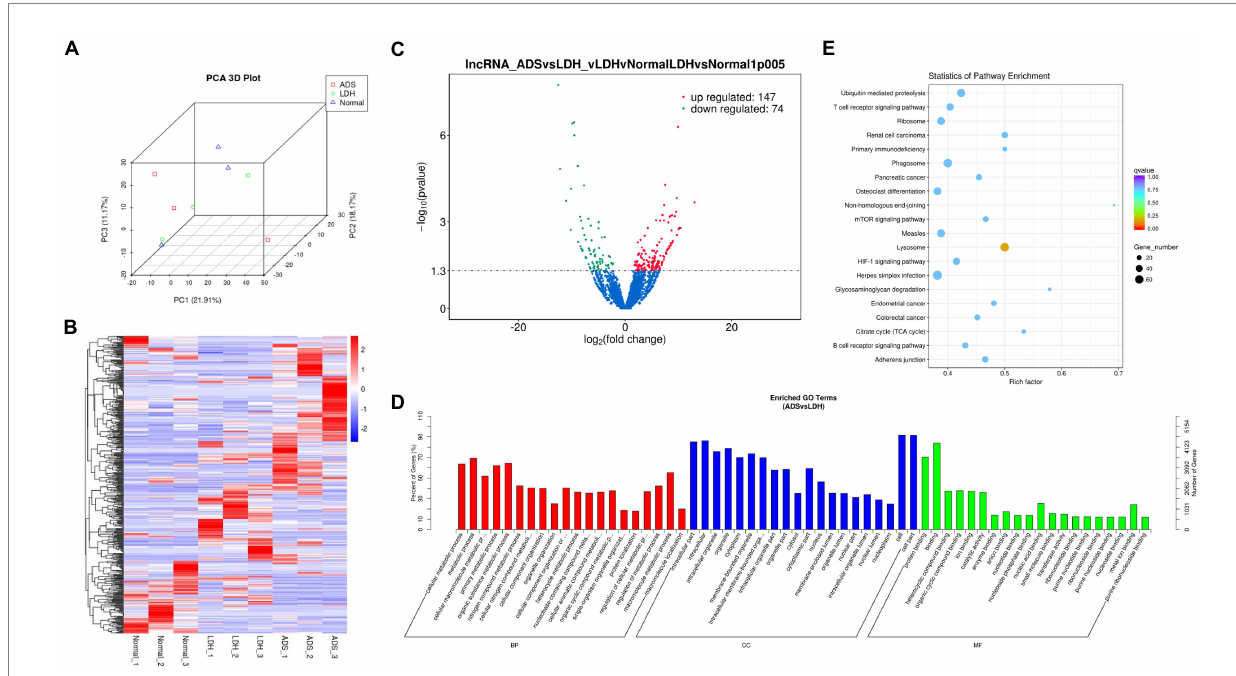
FIGURE 3 Identification of differentially expressed lncRNAs in ADS (A) Principal component analysis shows the clustering of lncRNA in different samples. (B) Hierarchical clustering illustrates distinguished expression difference of lncRNA and between the three groups and homogeneity between groups. (C) Volcano plot showing differentially expressed lncRNAs in ADS and LDH group. (D) The 20 most enriched Gene Ontology terms for the parental genes of the differentially expressed lncRNAs. Enriched GO terms are on the vertical axis, and the number of annotated differentially expressed genes associated with each GO term is indicated on the horizontal axis. (E) The 20 most enriched KEGG pathways for the differentially expressed lncRNAs. The size of the symbol represents the number of genes, and the colors represent p